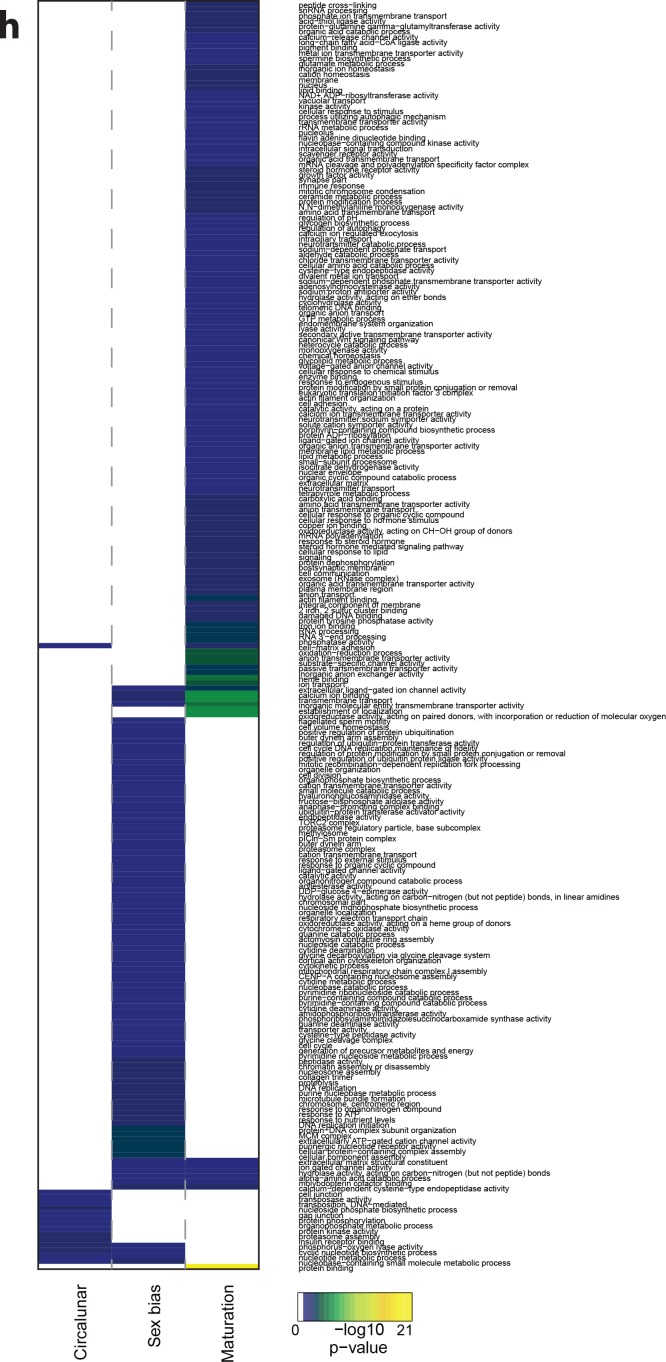
Heat map displaying over-represented GO-terms in all categories.The heat map is subdivided (columns) by the regulation of each GO-term by circalunar clock phase (left), sex (middle) and/or maturation (right); colours are indicative of the enrichment p-value as calculated by a hypergeometric test implemented in the GOStats package.